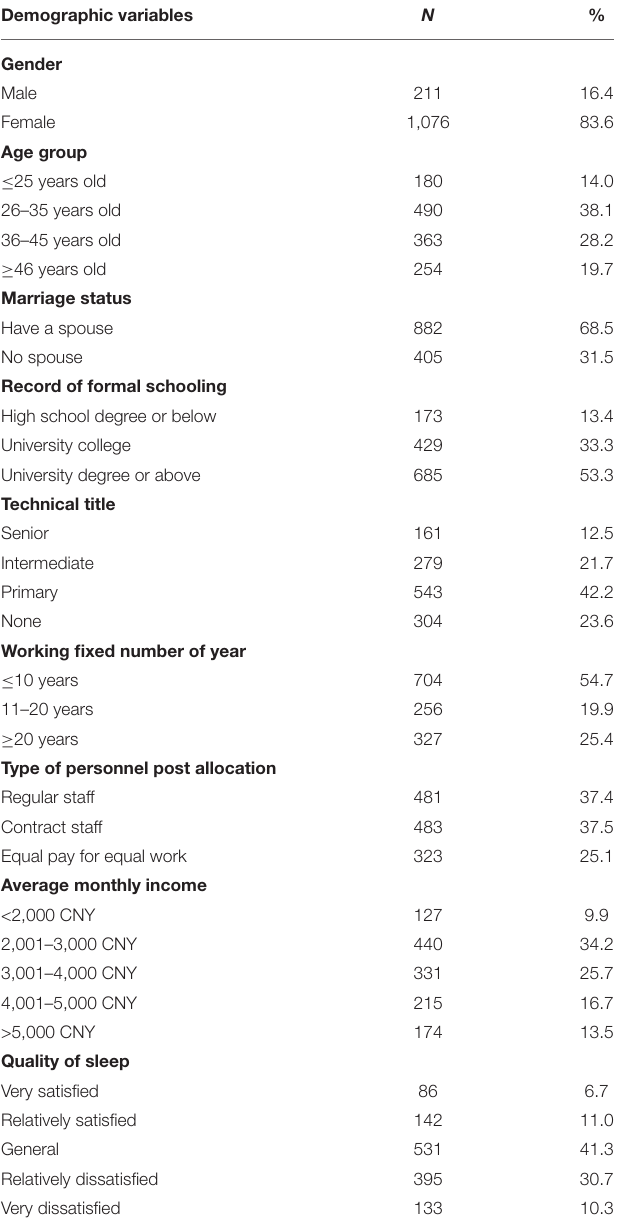
TABLE 1 | Demographic characteristics of the respondents( N =